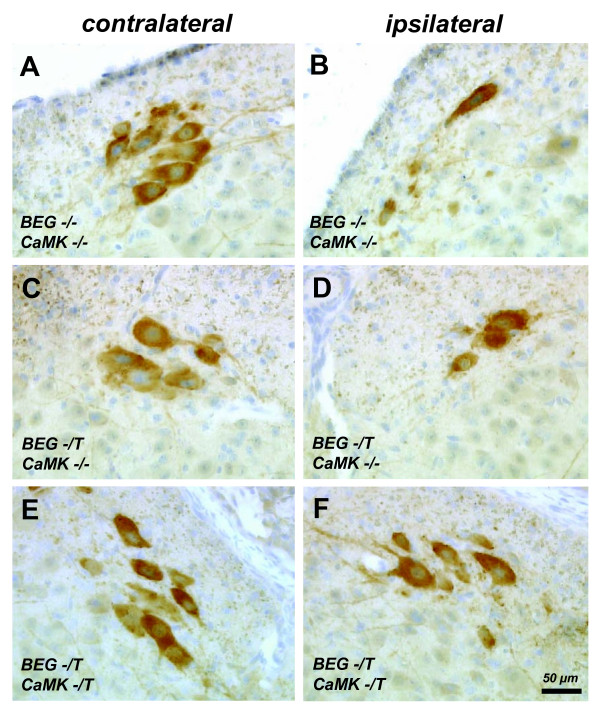
Examples of the histological evaluation of CHAT positive cells in the ventral horn of the lumbar spinal cord of neonatal mice after sciatic nerve axotomy. Sections from the lumbar spinal cord were stained with CHAT antibodies. (A, B) Examples of motoneurons in the ventral horn contralateral and ipsilateral to the lesion side in BEG -/- CaMK -/- mice (wild type littermates). (C, D) Examples of lumbar sections contra- and ipsilateral to the lesion from a BEG -/T CaMK -/- littermate (non-G-CSF expressing). (E, F) Examples of lumbar sections contra- and ipsilateral to the lesion from a G-CSF overexpressor (BEG -/T CaMK -/T mouse). (B, D, F) There are more CHAT-positive cells detectable 4 days after axotomy on the ipsilateral side in mice overexpressing G-CSF (BEG -/T CaMK -/T). All photomicrographs with 20× original magnification (OM), size bar 50 μM.